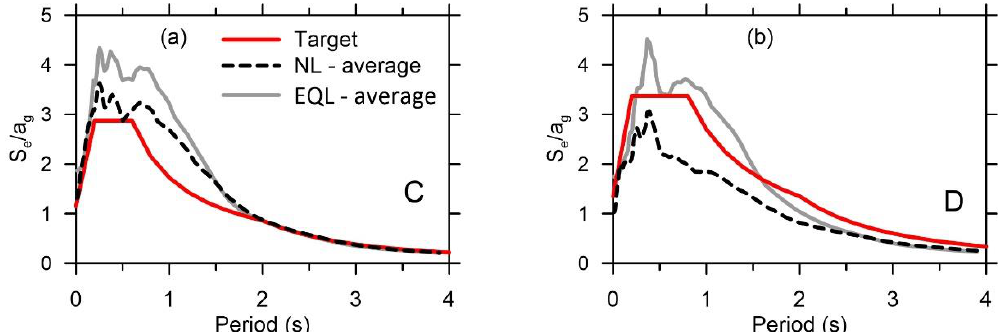
Figure 9. Spectral shape comparisons: ( a ) site classes C; ( b ) site classes D.